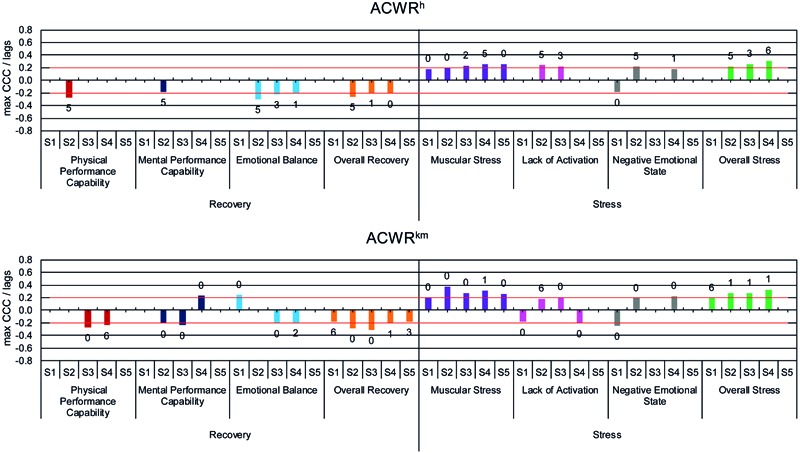
Maximum significant cross correlations (max CCC) between the dimensions of ARSS as lag variables and ACWRh and ACWRkm as lead variables with the associated time delay (lags) for the athletes S1–S5.